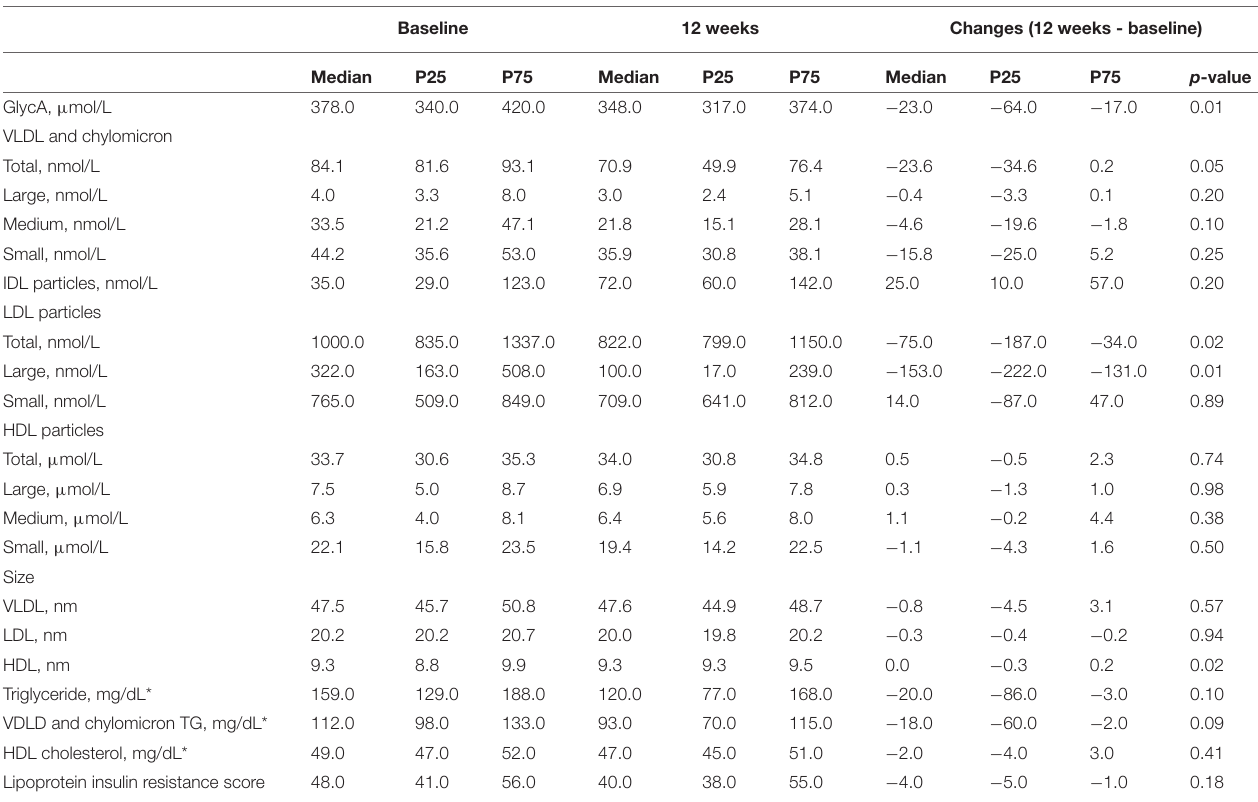
TABLE 3 | Nuclear magnetic resonance spectral analysis of GlycA and lipoprotein particles and size of the nine participants. Baseline 12 weeks Changes (12 weeks - baseline) Median